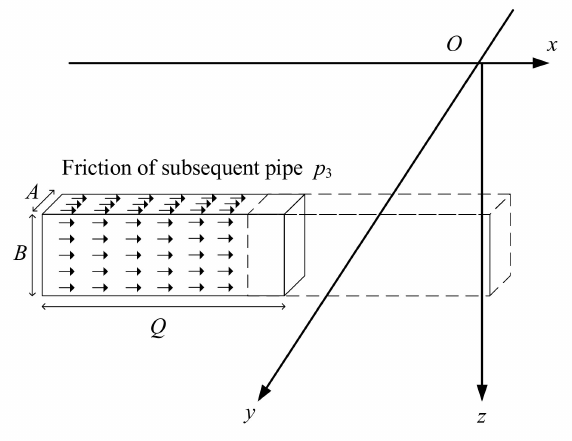
Figure 6. Areas of integration of subsequent pipe